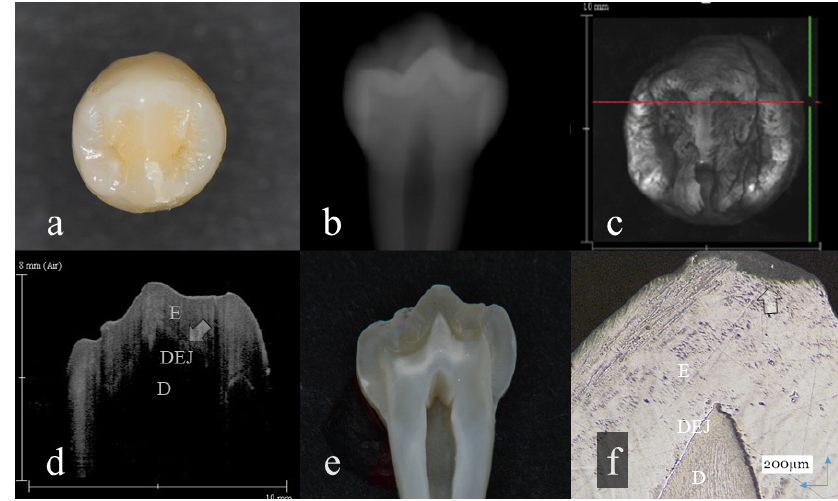
Figure 1. Slight enamel wear (score 1): ( a ): Occlusal view. Visibly, evidence of occlusal tooth wear was